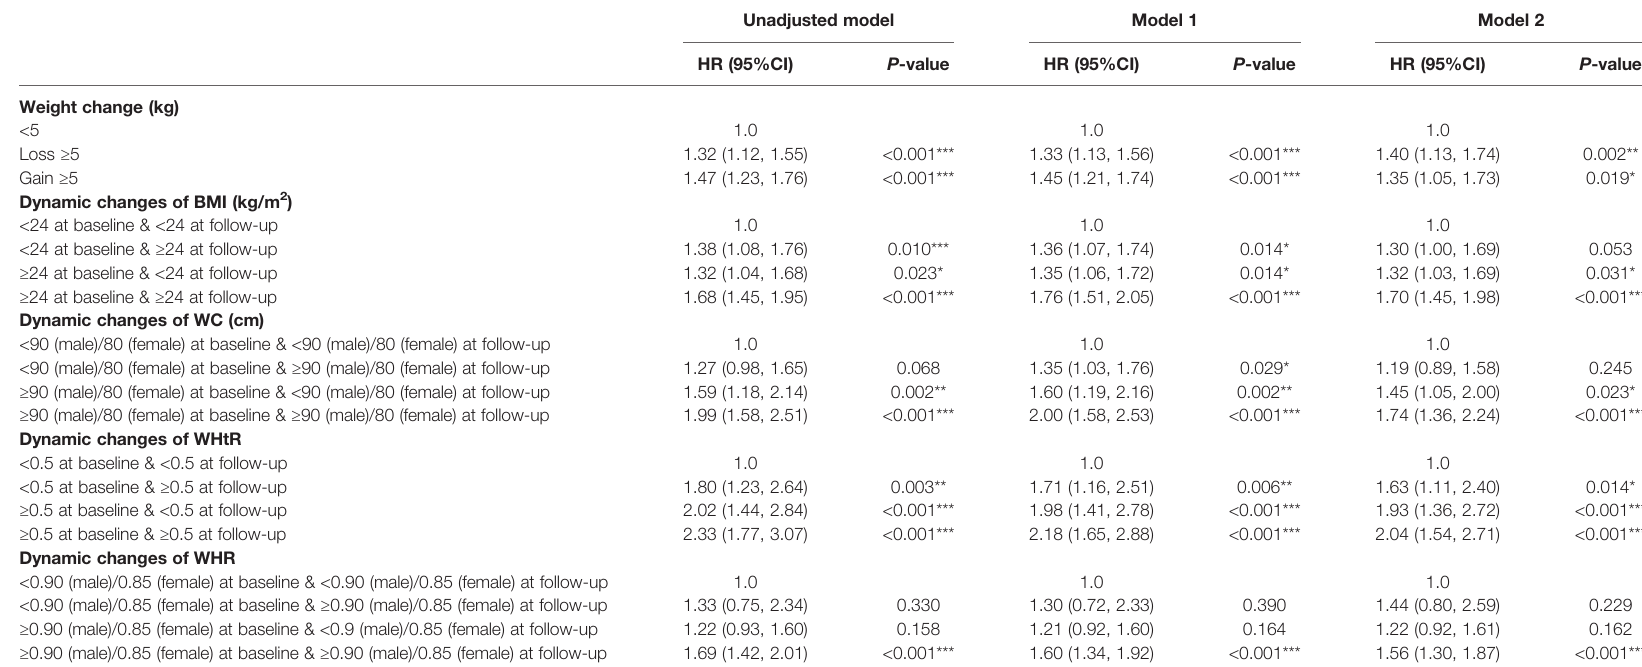
TABLE 4 | Multivariate cox regression models evaluating the associations of dynamic changes of established anthropometric indices with the development of